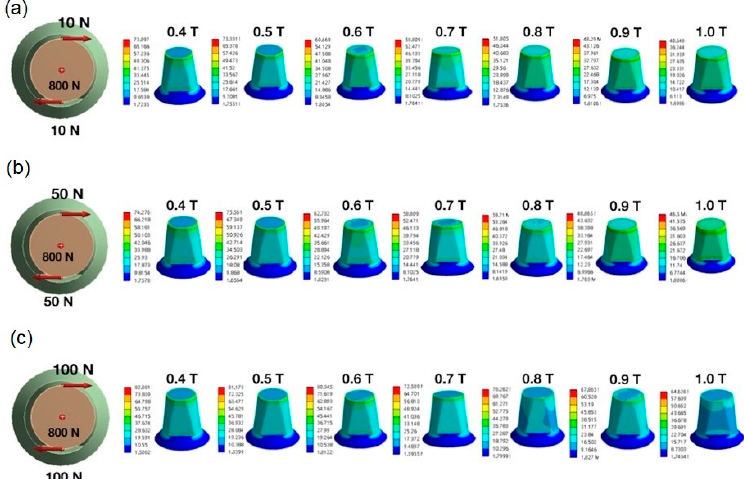
Figure 4. Distribution of stress in zirconia specimens. ( a ) Vertical load of 800 N with torque of 10 N. ( b ) Vertical load of 800 N with torque of 50 N. ( c ) Vertical load of 800 N with torque of 100 N. From left to right are the following loading models: 0.4 T, 0.5 T, 0.6 T, 0.7 T, 0.8 T, 0.9 T, and 1.0 T; T: thickness (mm).